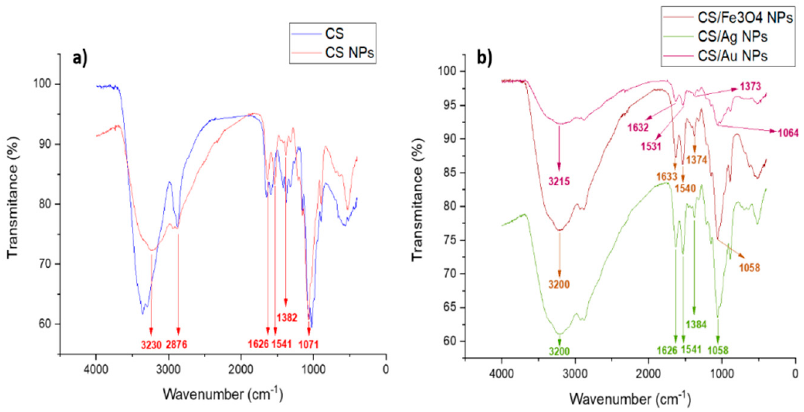
Figure 3. FT-IR spectra of ( a ) CS NPs compared to CS polymer and ( b ) hybrid CS based NPs.